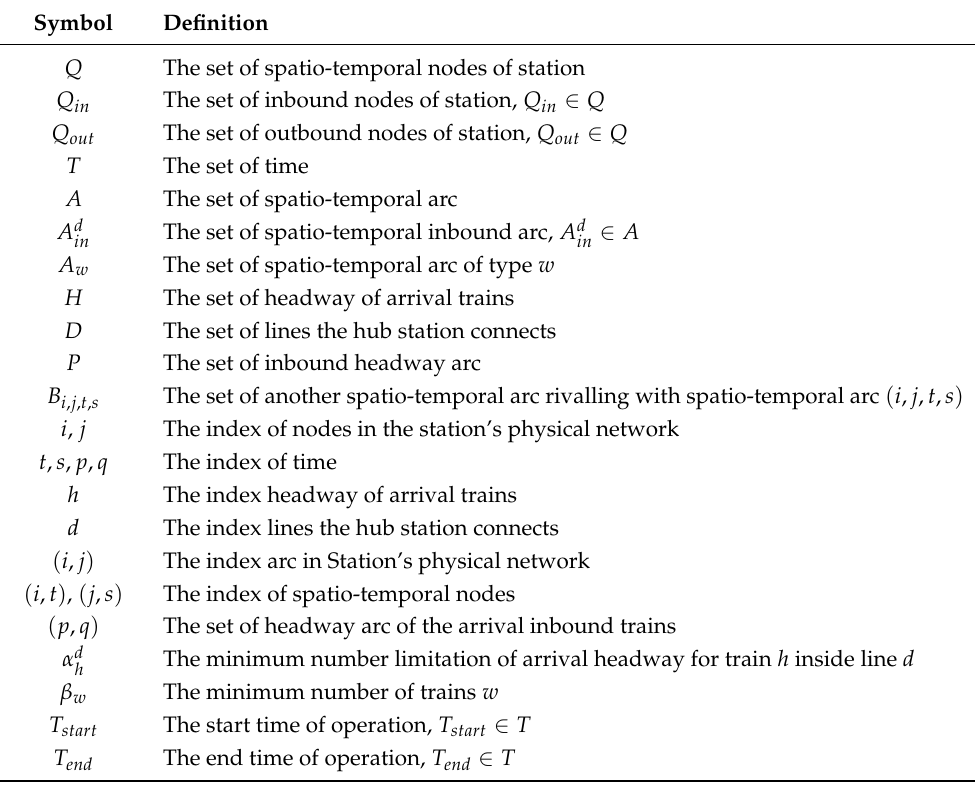
Table 1. Sets, indices, and parameters.